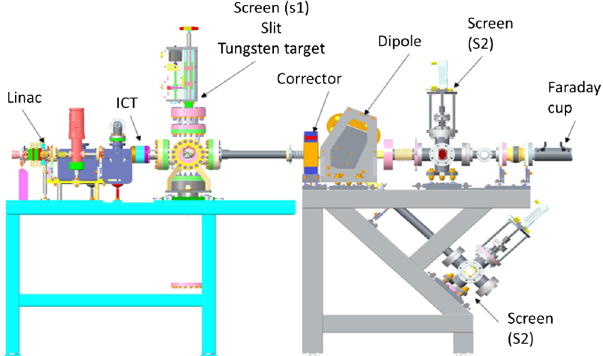
FIG. 17. Experimental layout with beam diagnostics. The overall length of the beam line from the linac gun to the Faraday cup is